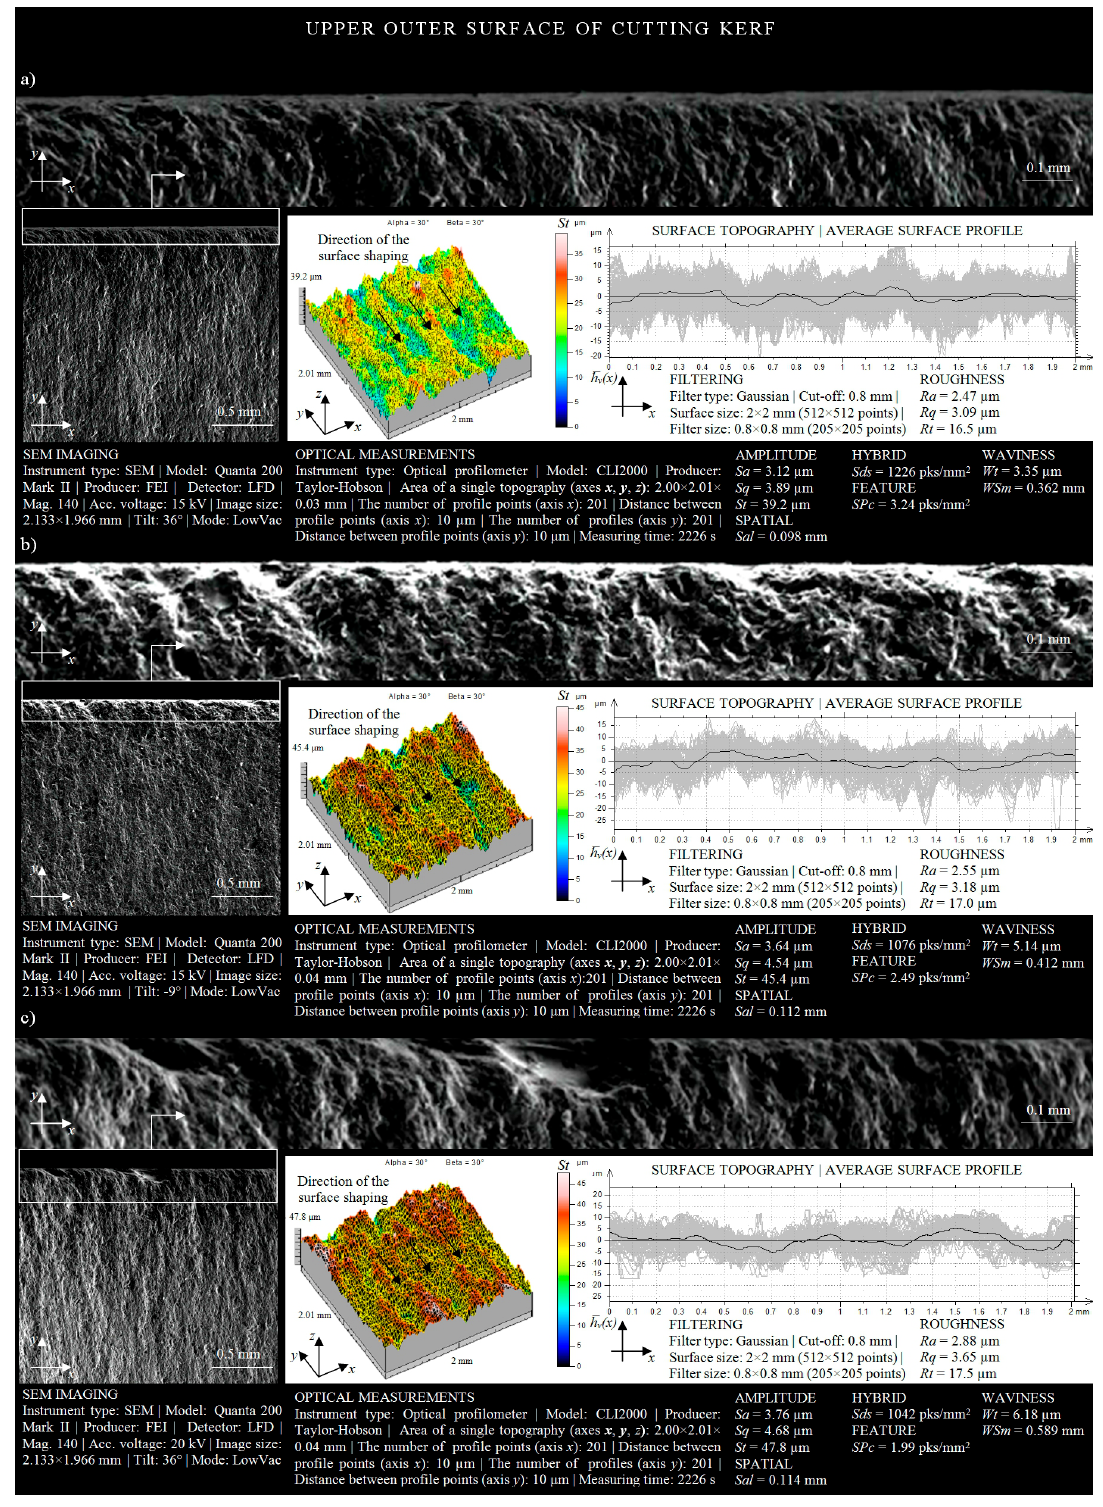
Figure 8. Collection of selected results of experimental studies obtained for the upper OS in a situation where the AWJ entered the sample surface ( l = 1.5 mm, d o = 0.38 mm, d f = 0.76 mm, m a = 0.336 kg / min, v = 427 mm / min, p = 360 MPa, g = 8 mm): ( a ) r = 50 mm; ( b ) r = 35 mm; ( c ) r = 15